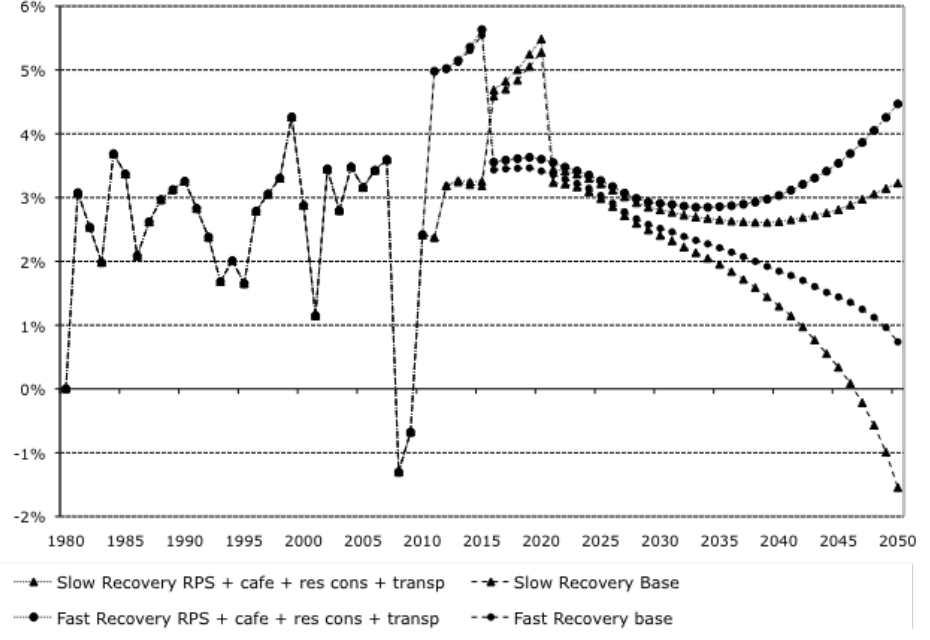
Figure 2. Results of the simulation of T21-USA, Real GDP growth rate (percentage/year). RPS = renewable portfolio standard; CAFE = corporate average fuel economy; RES CONS = residential energy conservation; TRANSP = electrified